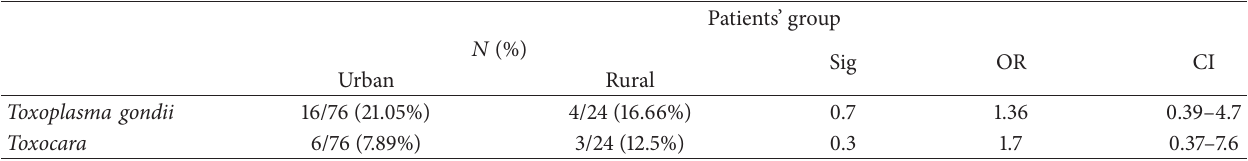
Table 6: The distribution of Toxoplasma gondii and Toxocara antibodies in patients with schizophrenia disorder based on their residential area.